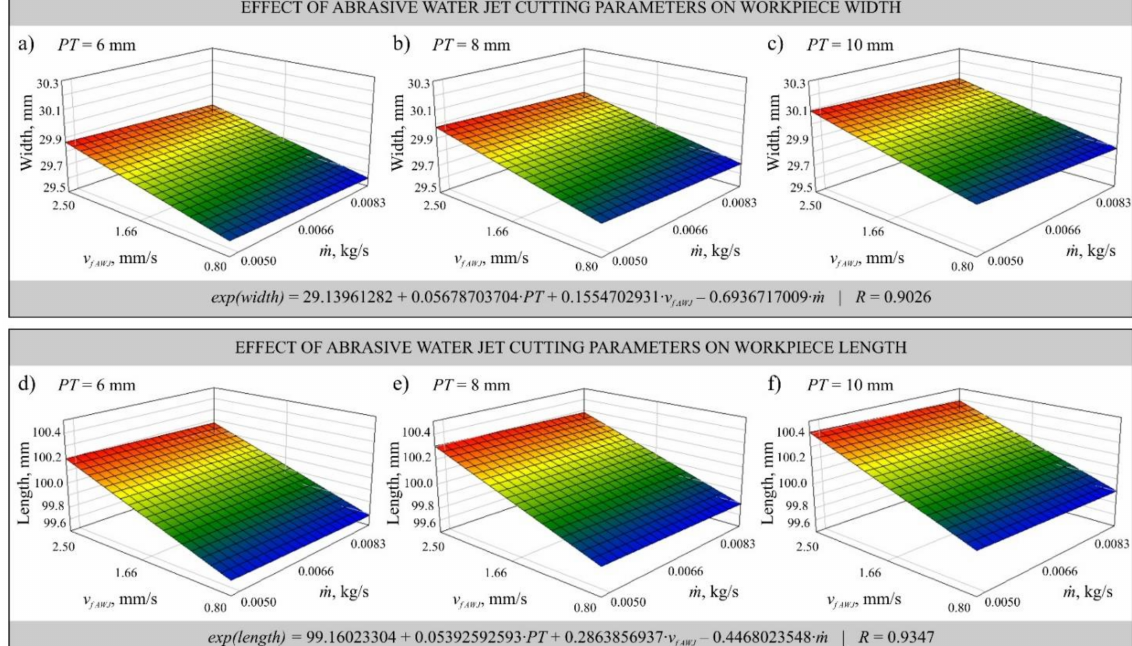
Figure 4. Mathematical models developed using data from measurements of the width ( a – c ) and length ( d – f ) of elements cut by laser beam from plate of thickness PT = 6 mm ( a , d ), PT = 8 mm ( b , e ) and PT = 10 mm ( c , f ) as a function of changes in the laser head feed rate v f LASER and laser power P .